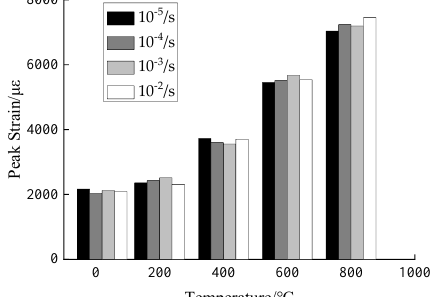
Figure 15. Peak strain of concrete.